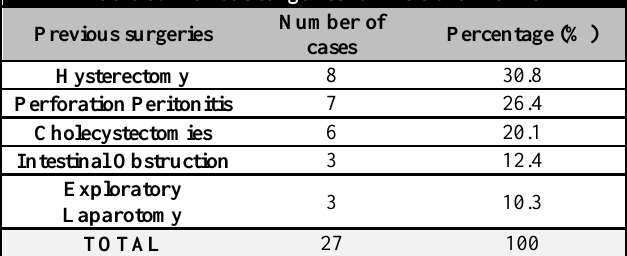
Table 5. Previous surgeries for incisional